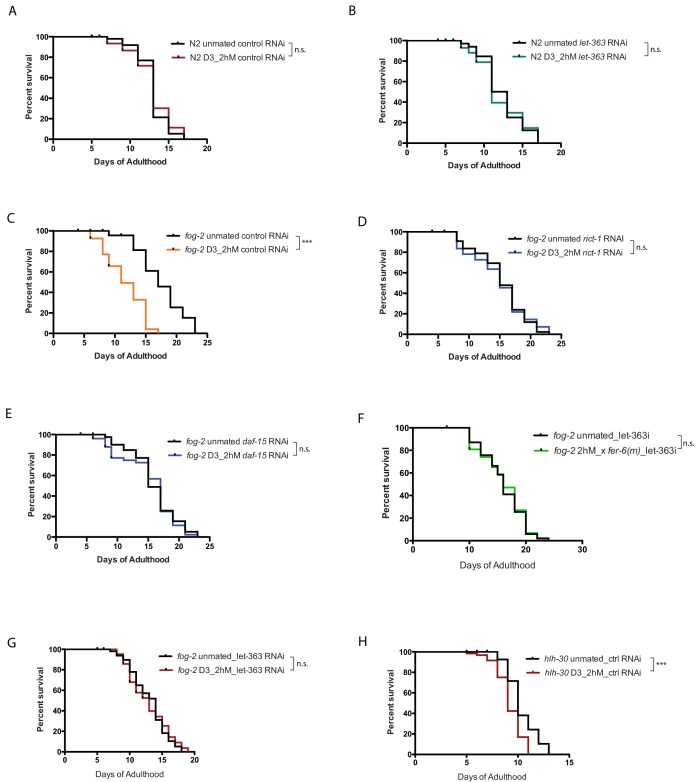
TOR signaling mediates self-sperm protection from brief mating.(A–B) Knockdown of let-363 has no impact on lifespan of N2 upon brief mating. (A) N2 on vector control RNAi unmated: 14.9 ± 0.3 days; mated: 14.9 ± 0.4 days, p=0.7888. (B) N2 on TOR/let-363 RNAi unmated: 12.3 ± 0.5 days; mated: 12.1 ± 0.6 days, p=0.8791. (C–F) Individual TOR components knockdown prevents SF killing in spermless females. (D) fog-2;rict-1(RNAi) unmated: 15.2 ± 0.6 days; mated: 14.9 ± 0.6 days, p=0.8375. (E) fog-2;daf-15(RNAi) unmated: 15.9 ± 0.6 days; mated: 15.2 ± 0.6 days, p=0.6903. (C) fog-2; control (RNAi) unmated: 17.4 ± 0.8 days; mated: 11.7 ± 0.6 days, p<0.0001. (F) Knockdown of let-363 in self-spermless fog-2 protects the hermaphrodites from SF killing. fog-2 on TOR/let-363 RNAi unmated: 16.0 ± 0.5 days; mated with fer-6 males: 16.0 ± 0.6 days, p=0.8488. (G–H) Lifespan control for Figure 5G. (G) fog-2 on TOR/let-363 RNAi unmated: 13.0 ± 0.4 days; mated: 12.9 ± 0.4 days, p=0.8275. (H) hlh-30 on vector control RNAi unmated: 10.4 ± 0.2 days; mated: 9.2 ± 0.2 days, p<0.0001.